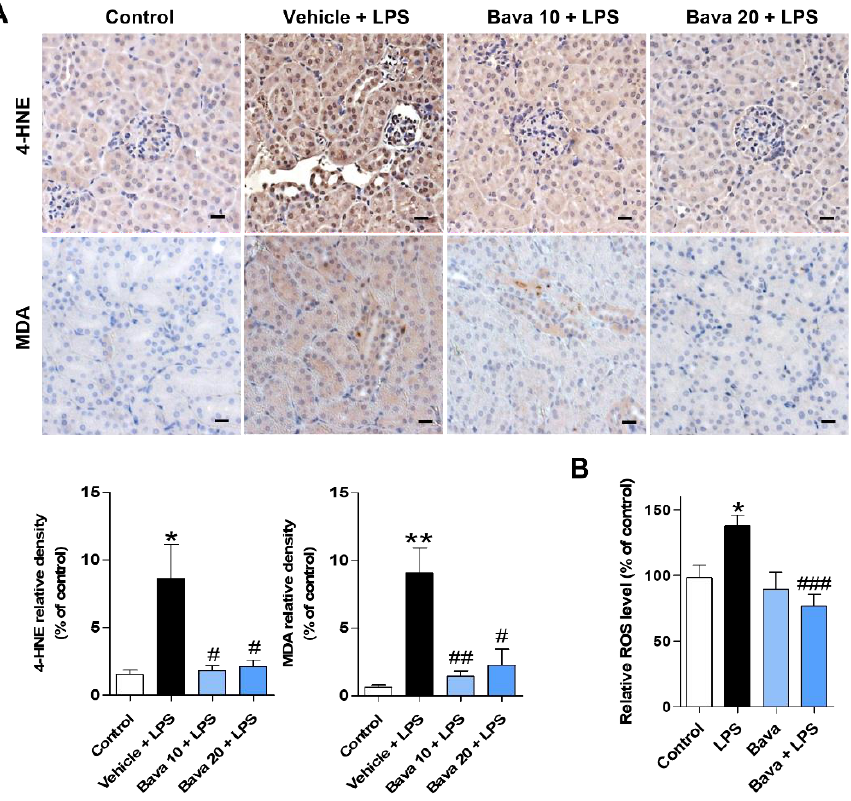
Figure 3. Bavachin decreases ROS production in LPS-induced AKI mice and LPS-treated HK-2 cells. ( A ) Immunohistochemical detection of 4-hydroxynonenal (4-HNE) and malondialdehyde (MDA), as markers of ROS generation, was performed in kidney tissues using DAB. Nuclei were counterstained with hematoxylin (original magnification, 200 × ; scale bars, 20 µ m; n = 3 mice per group). Bottom: Relative expression densities of 4-HNE and MDA quantified using ImageJ software. ( B ) HK-2 cells were seeded in a 96-well black plate, pretreated with 0.1 µ g/mL bavachin for 1 h, and then treated with 5 µ g/mL LPS for 1.5 h. Intracellular ROS levels were measured using a VICTOR Nivo™ multimode plate reader using a fluorometric assay with DCFH-DA. The relative levels of ROS by DCF fluorescence intensity were compared to those in the control. Data are presented as mean ± SEM. * p < 0.05, ** p < 0.01 vs. control; # p < 0.05, ## p < 0.01, ### p < 0.005 vs. vehicle + LPS or